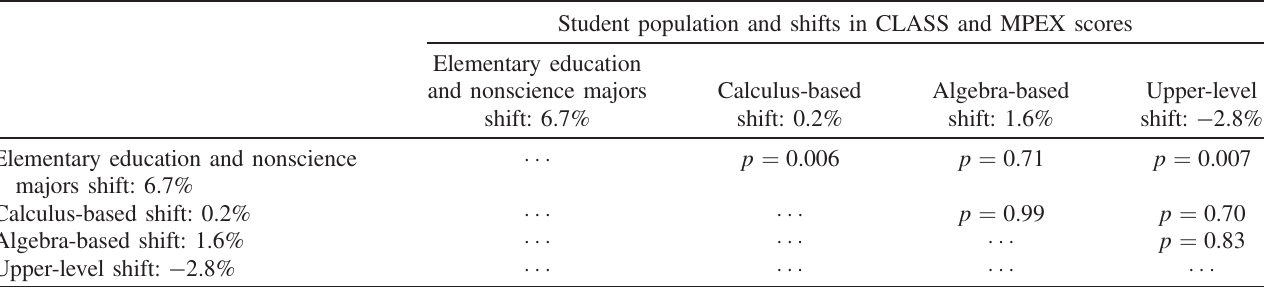
TABLE IX. Significant results of statistical comparison between student populations using Tukey HSD post hoc contrasts. Courses for elementary education and nonscience majors have significantly greater shifts than calculus-based or upper-level courses.